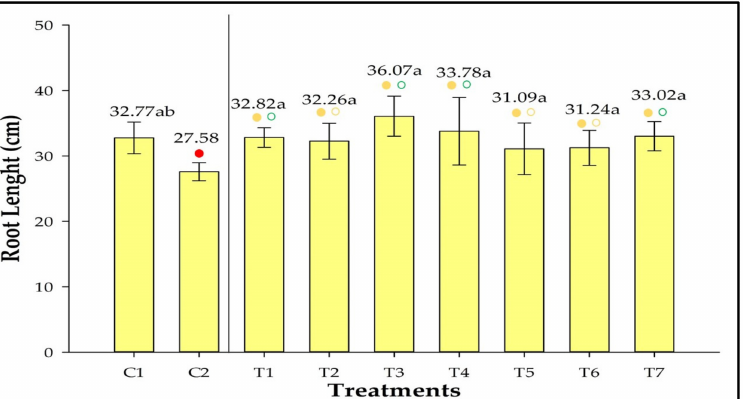
Figure 6. Root length of strawberries inoculated with Azospirillum brasilense , Bacillus megaterium , and Brevibacillus fluminis , alone and in mixtures. Closed ( ) circles indicate comparisons withs Controls 1 (C1) and 2 (C2), respectively. Green, yellow, and red circles indicate that the values are higher than, equivalent to, or lower than those observed in the controls according to Dunnet’s test ( p ≤ 0.05). Means followed by the same letter do not differ statistically according to Duncan’s test ( p ≤ 0.05). C1: control without inoculation + fertilization 100% of N and P; C2: control without inoculation + fertilization 30% of N and P; T1 : Azospirillum brasilense (Ab-v5); T2: Bacillus megaterium (0004); T3: Brevibacillus fluminis (MET12M2); T4: Ab-v5 + 0004; T5: Ab-v5 + MET12M2; T6: 0004 + MET12M2; T7: Ab-v5 + 0004 + MET12M2.